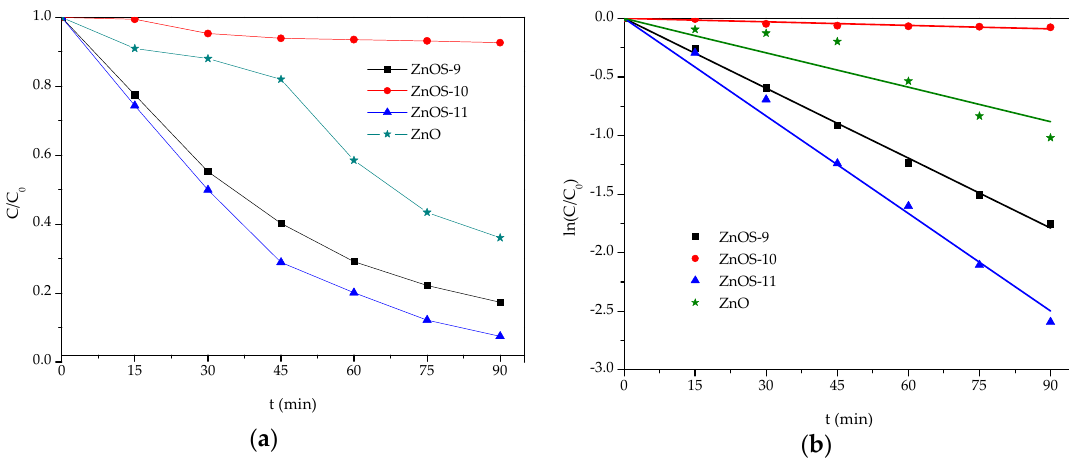
Figure 6. ( a ) Rhodamine B degradation rate for the different photocatalysts as-synthesized, ( b ) The pseudo-first order kinetic photocatalytic degradation of Rhodamine B for the ZnOS samples.